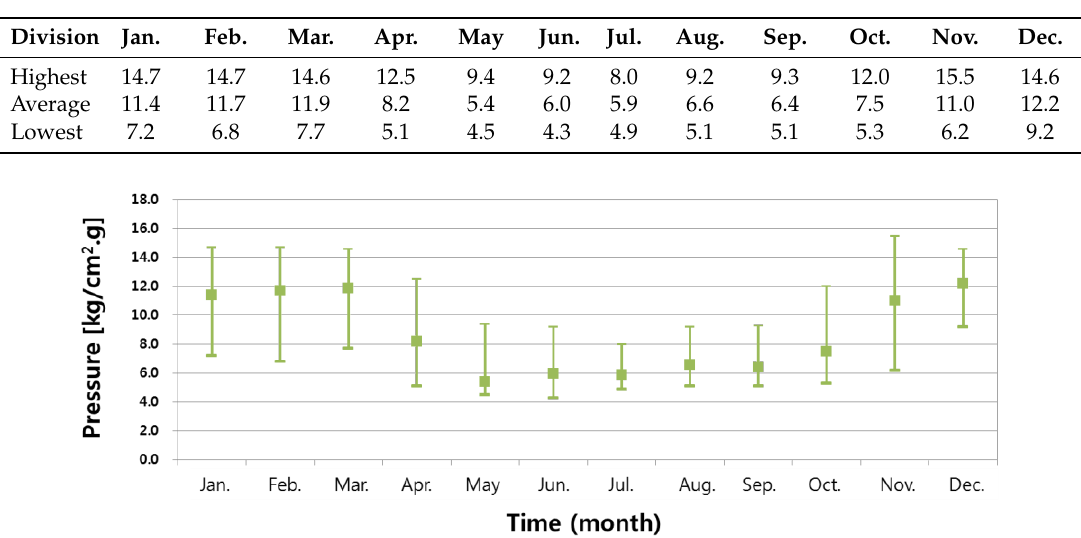
Figure 3. Temperature distributions of district heating (DH) supply and return water for a year.